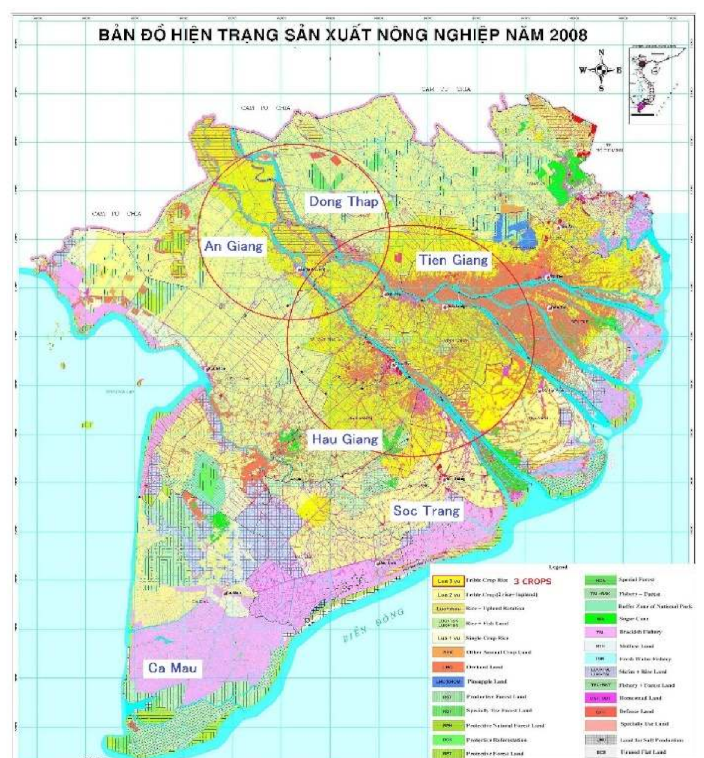
Figure 2. Mekong Delta Agricultural land use map (2008). * The yellow-colored area is for rice cultivation, and circled areas are mostly triple cropping areas. Land use areas have not changed for most of the Mekong Delta areas since this 2008 map up to 2014, except for some expansion of triple cropping areas from two cropping areas by irrigation system improvements. Source: Southern Institute for Water Resources Planning (SIWRP)